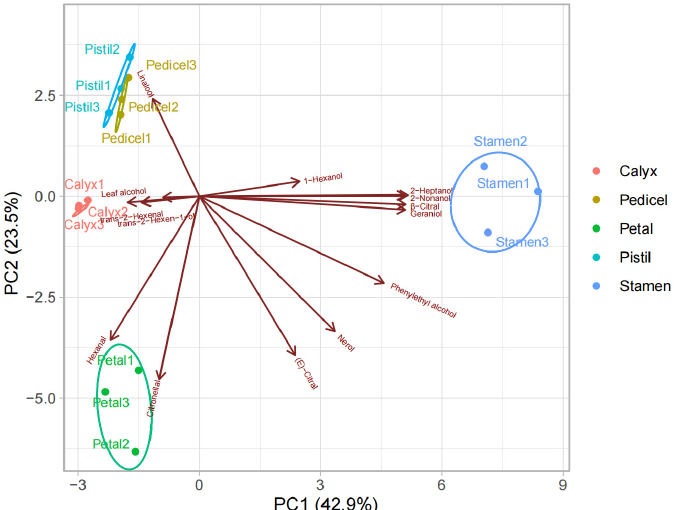
Figure 8. PCA biplot based on VOCs from five floral organs. Only compounds with the highest relative content were shown.